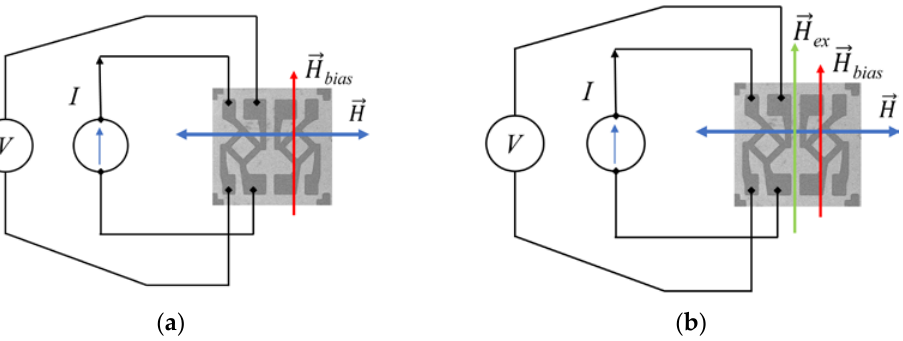
Figure 12. Measurement schematic for the AMR bridge sensors: ( a ) For the thermally annealed chip; ( b ) For the thermally and magnetically annealed chip.